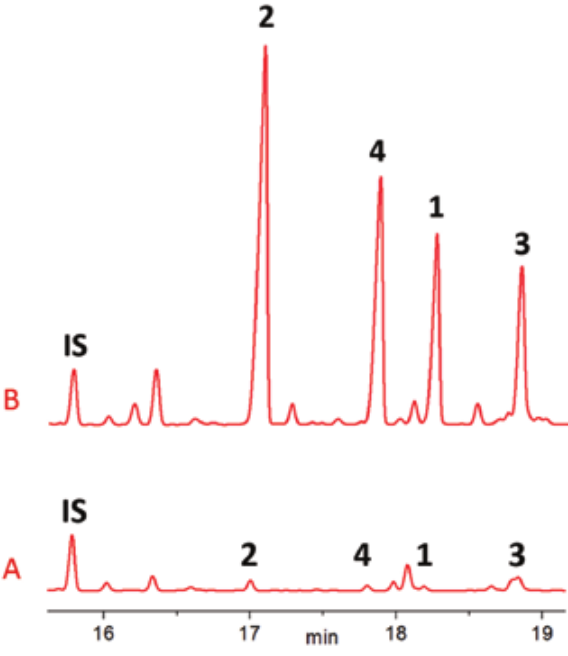
Figure 7. The chromatogram of turpentine before (A) and after 20 days of autooxidation (B).